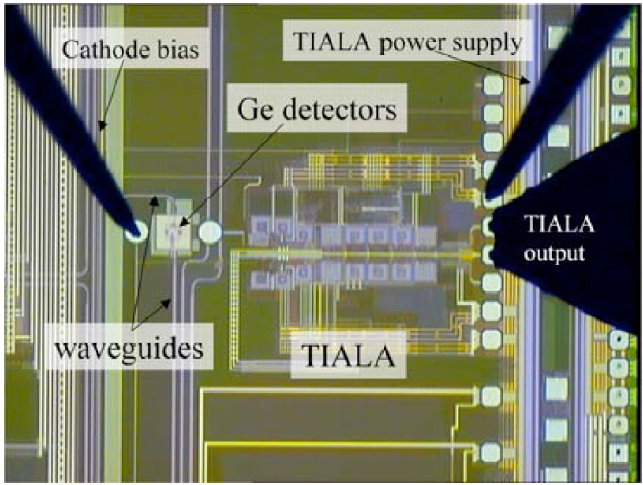
Figure 11. A four-channel, 10 Gbps monolithic optical receiver in 130 nm CMOS with integrated Ge waveguide photodetectors. From [24].